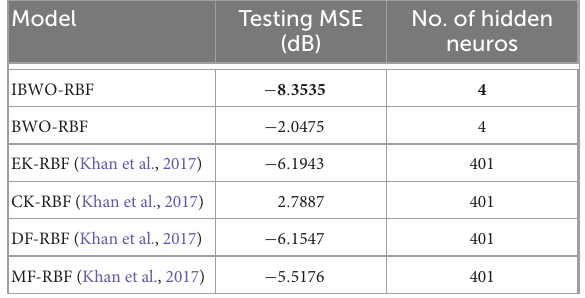
TABLE 7 Comparison of six models for the nonlinear system